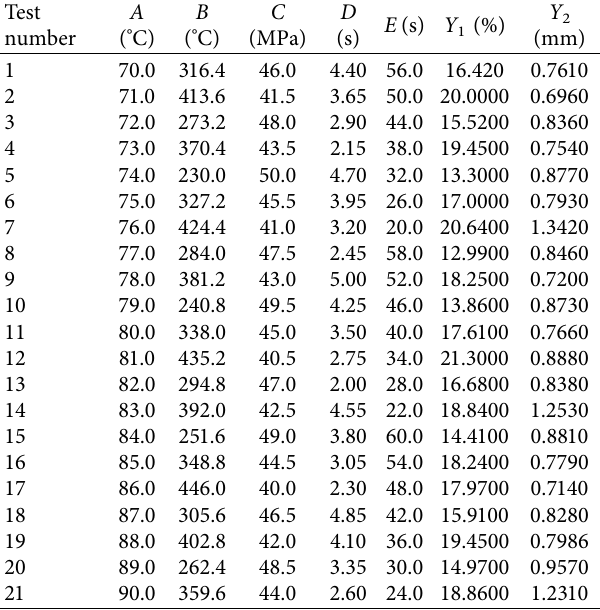
Table 5: Uniform design of the test scheme and statistical table of results.